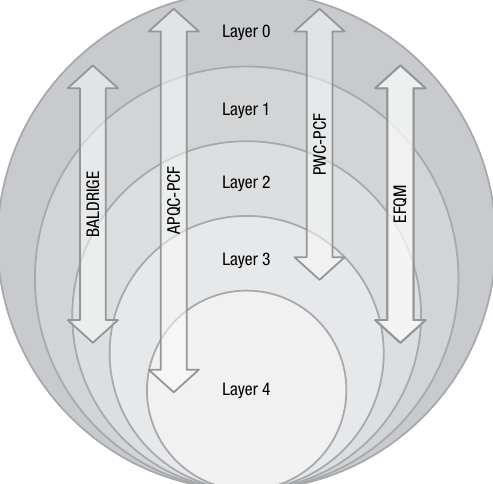
Fig. 2. The depth as dimension of complexity in the analyzed frameworks Source: created by